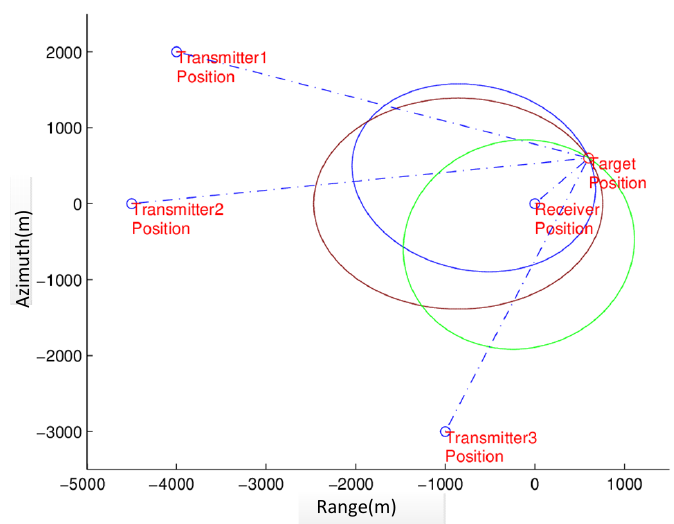
Figure 7. Transmitters, receiver and bistatic SAR (BSAR) iso-range